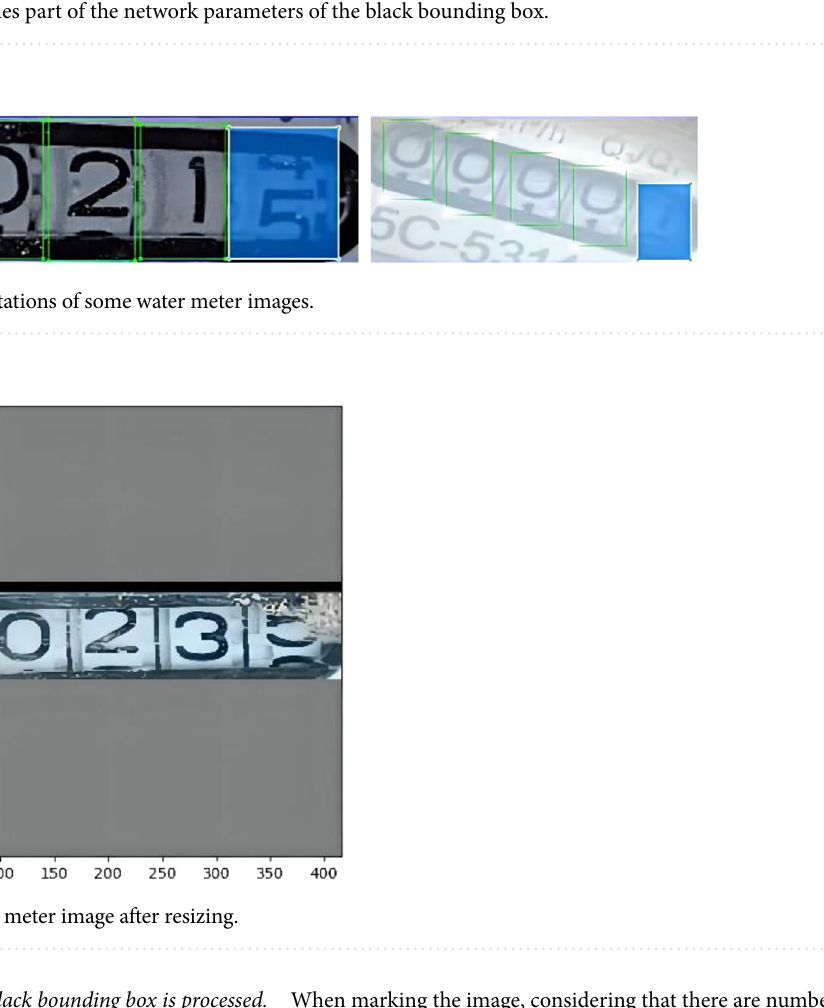
Table 2. Identifies part of the network parameters of the black bounding box.